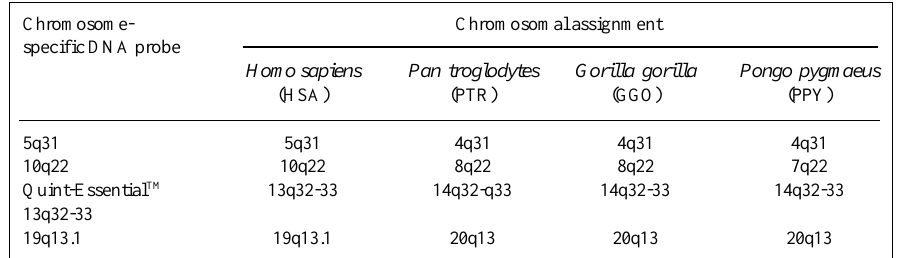
Table I - Summary of localization of chromosome-specific DNA probes in the great ape species.